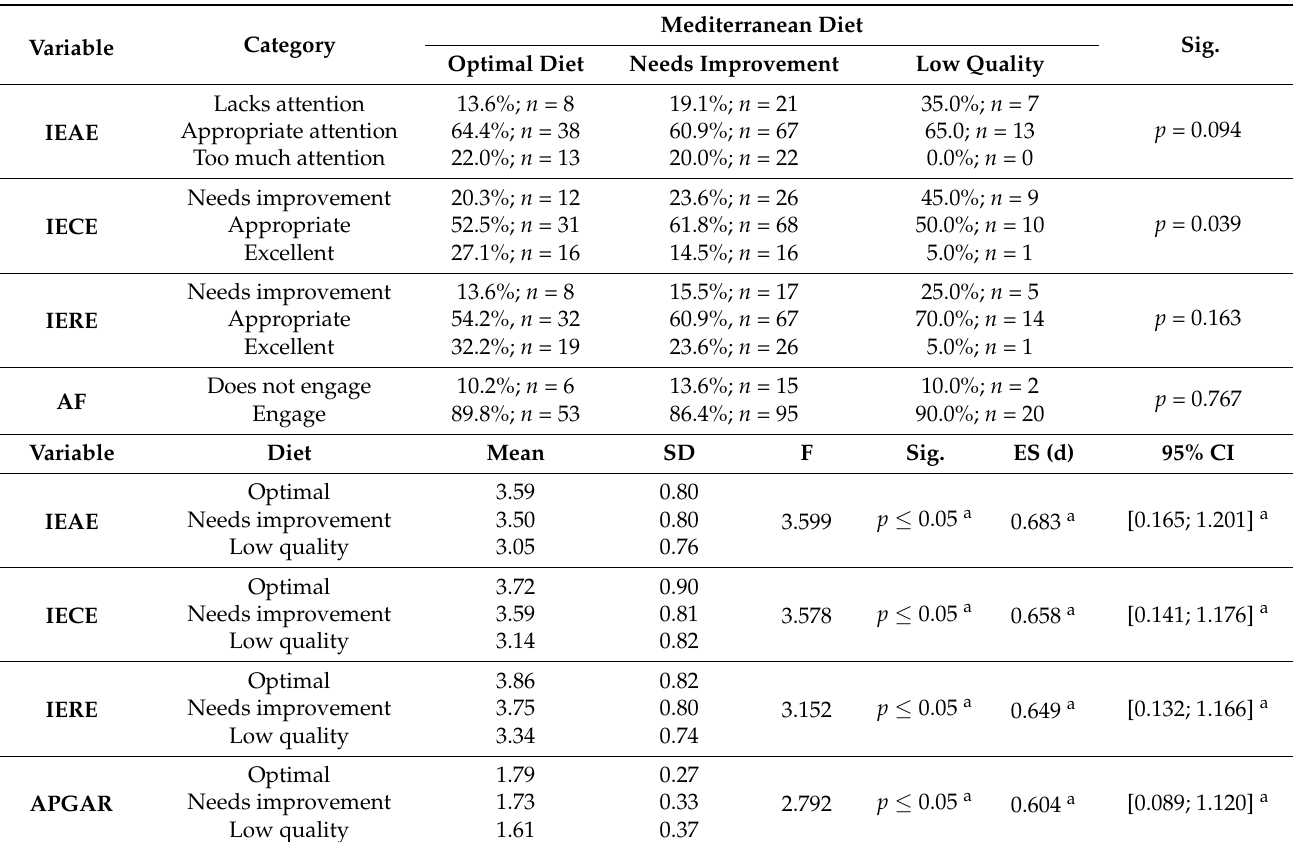
Table 4. Relational study pertaining to the Mediterranean diet adherence